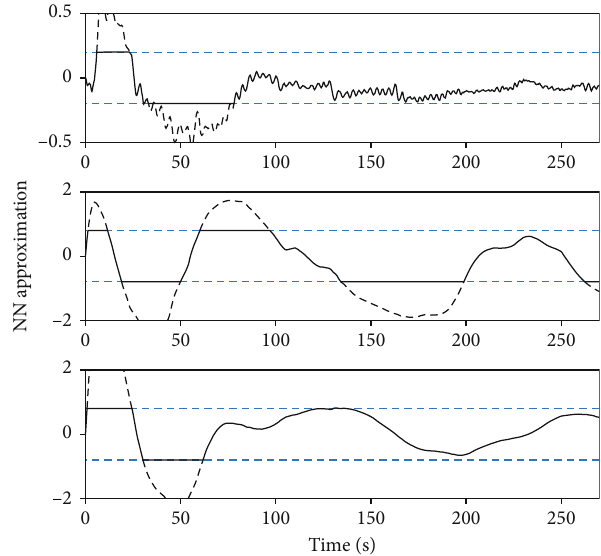
Figure 9: Experimental result: output of NN in Case 2.